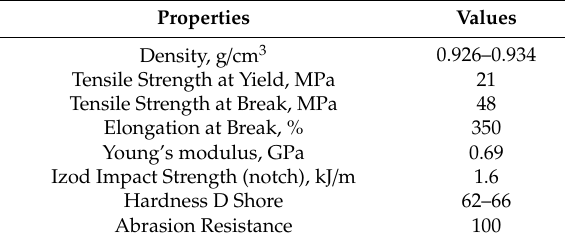
Table 10. Properties of the material used by the “Ticona LLC”